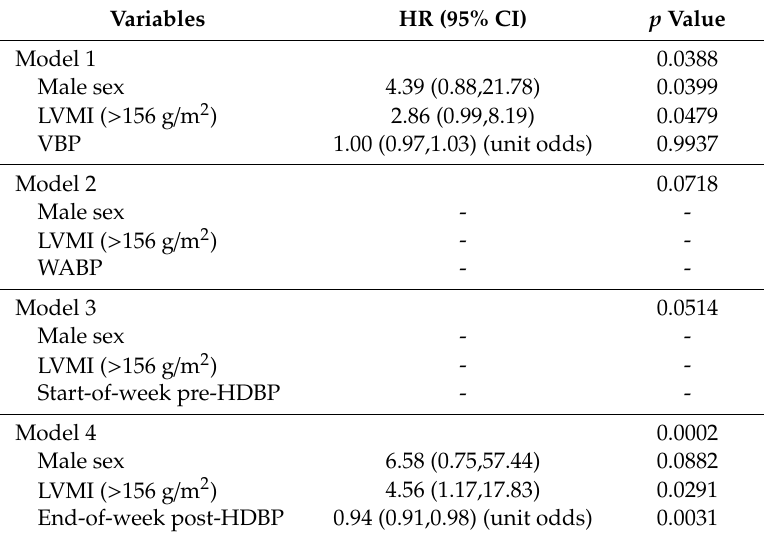
Table 5. Adjusted hazard ratio for past CV